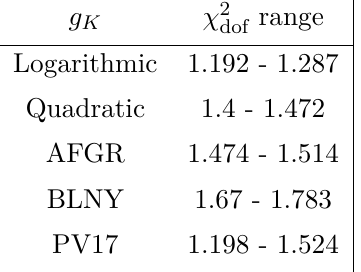
Table 3 . Range of the χ 2